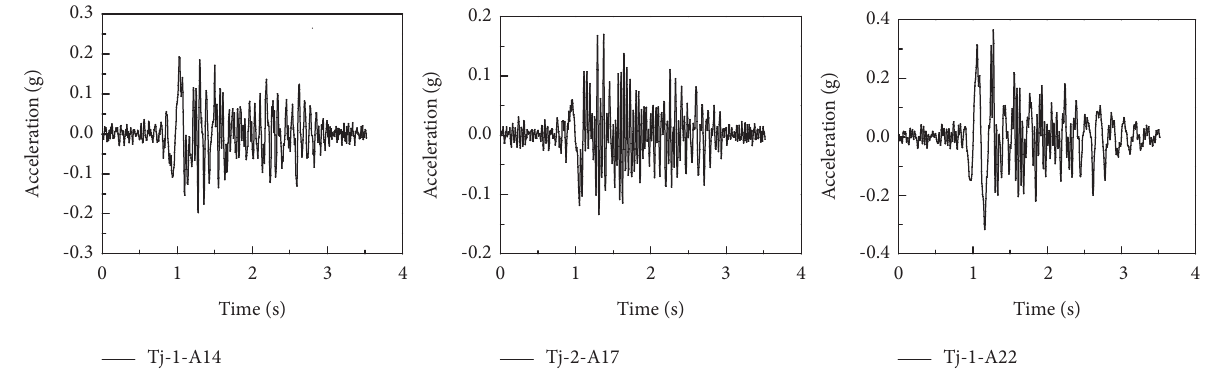
Figure 11: Acceleration time history of A14, A17, and A22 of the surface structure-pile